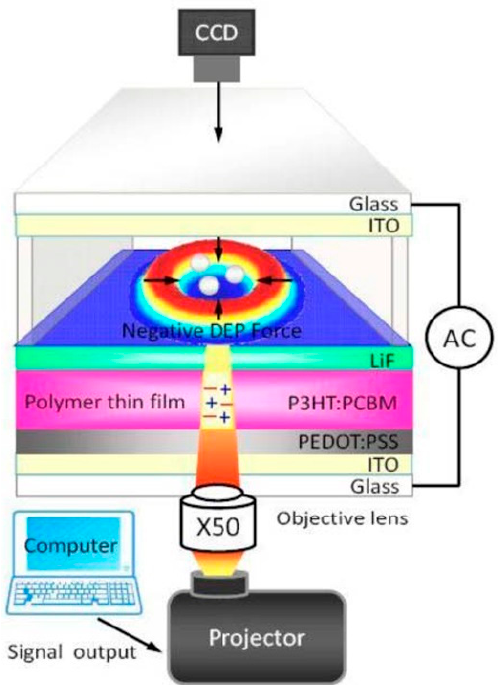
Figure 2. Structure of P3HT / PCBM polymer-based OEK chip (reproduced from Ref. [47]).